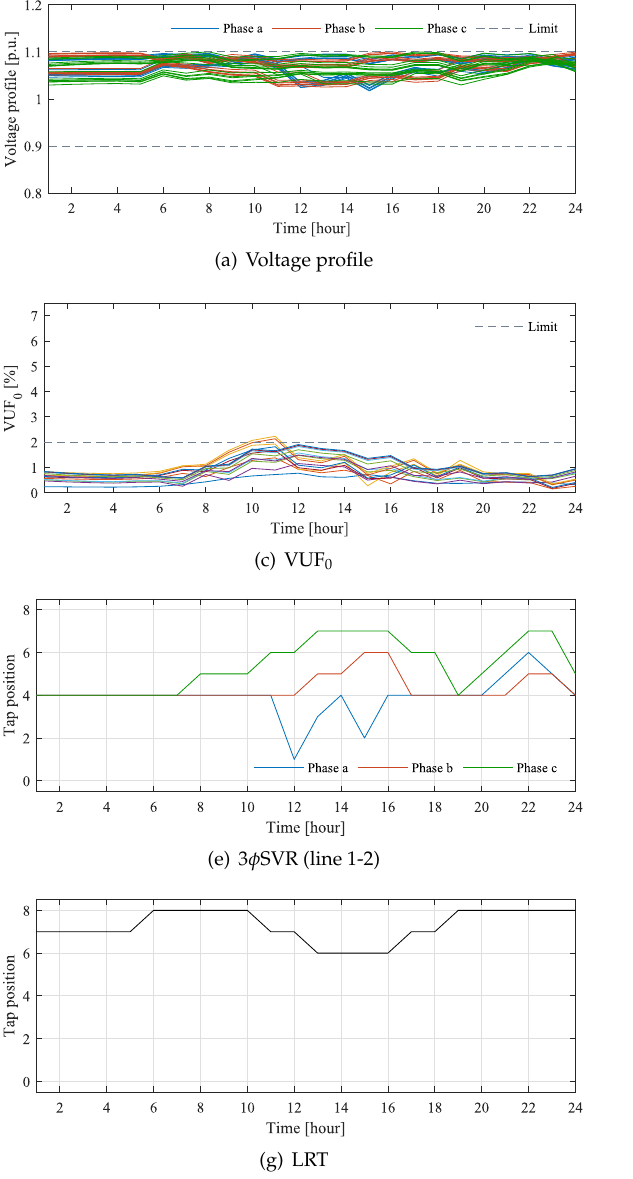
Figure 7. Simulation result of Case 3: minimize losses; the different colors in ( b – d ) refer to different buses. All unbalance metrics considerably improves even though they are not taken into account; VUF is within 2% for all buses, but other metrics exceed 2% for few buses.